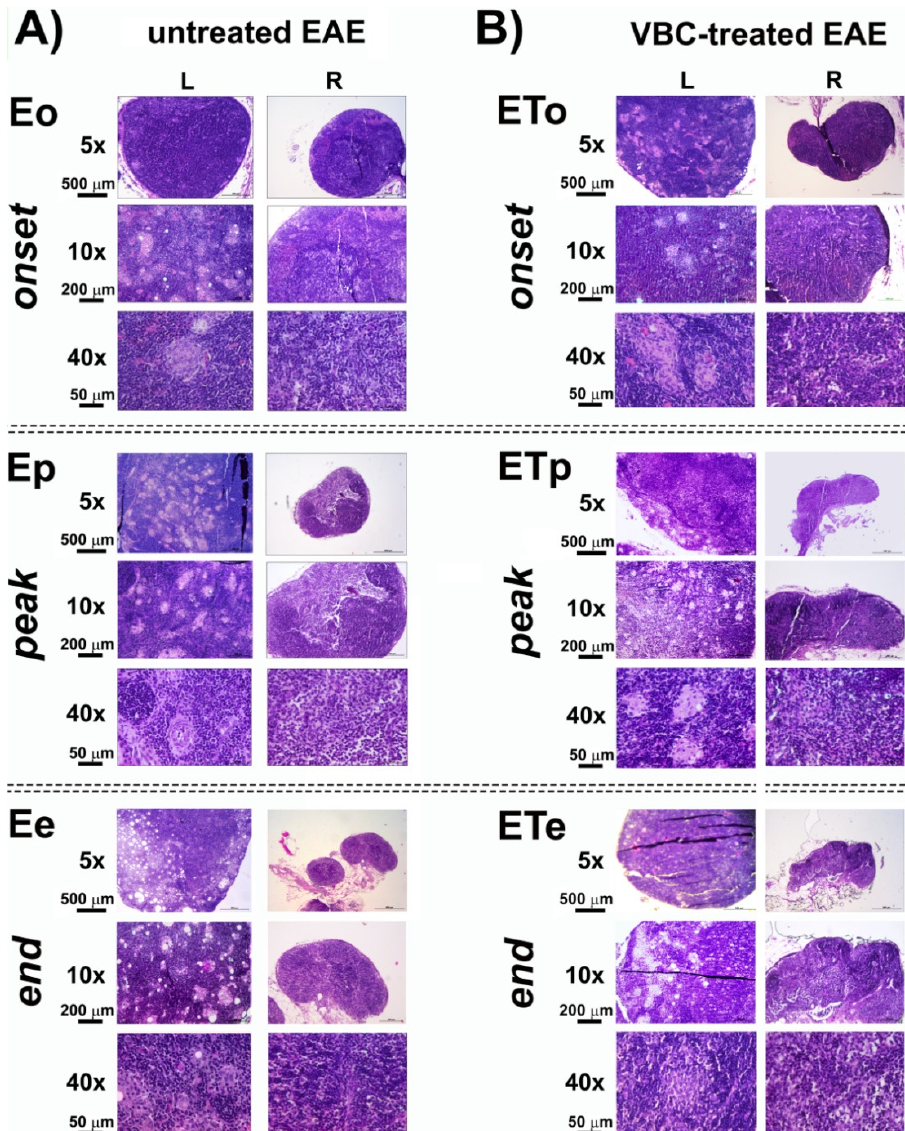
Figure 3. Histological changes in popliteal lymph nodes structure of untreated EAE rats ( A ) and VBC-treated EAE rats ( B ). Micrographs of transverse sections of H&E stained lymph nodes (left— L and right— R ) in three different time points: onset ( o ), peak ( p ), and end ( e ) of the disease. Magnification 5× (scale bar 500 μ m), 10× (scale bar 200 μ m), and 40× (scale bar 50 μ m).